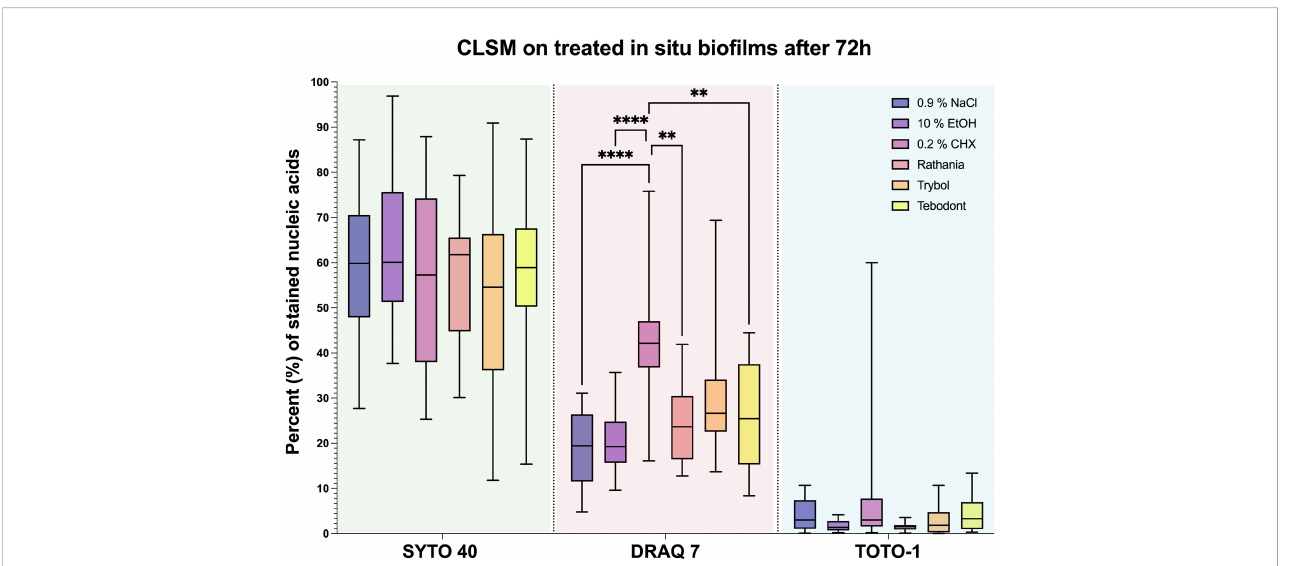
FIGURE 6 Boxplots illustrating the outcomes of image analysis. The in situ bio fi lm was grown 72 hours on HA discs and afterwards treated with different mouthrinses: 0.2% CHX, 10% EtOH, 0.9% NaCl, Ratanhia, Tebodont and Trybol. The visualization of nucleic acids was aided by SYTO 40, a cell-permeant nucleic acid stain, as well as DRAQ7 and TOTO-1, which cell impermeable DNA dyes. The percentage of stained nucleic acids was measured. The line dividing the box shows the median. The p-values of the signi fi cantly different data are plotted: ** = P-value < 0.01., **** = P-value < 0.0001.